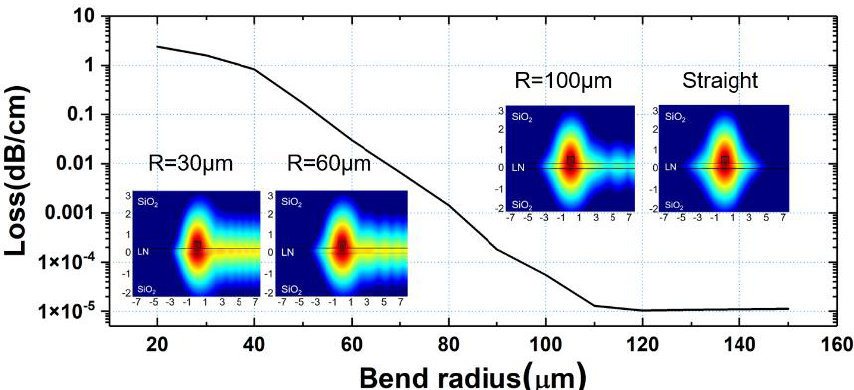
Figure 6. Relationship between the bend radius and optical loss. Simulations of the logarithmic mode profile corresponding to R = 30 μm, 60 μm, 100 μm and straight waveguide are reported in the insets.